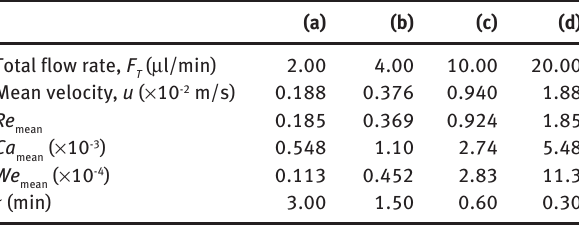
Table 3 Experimental conditions and dimensionless quantity estimates.